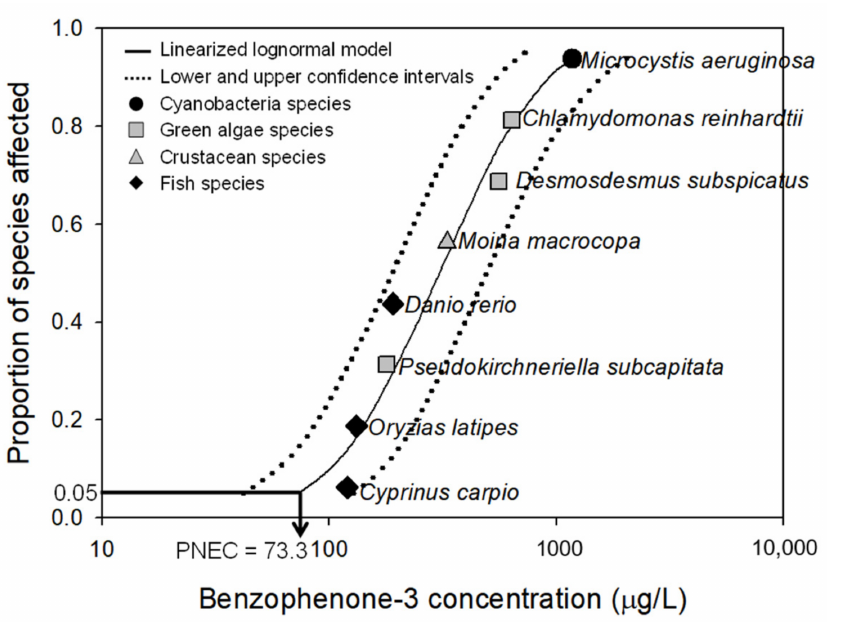
Figure 3. Species sensitivity distribution (SSD) for the chronic toxicity of benzophenone-3. Predicted no-effect concentration (PNEC) was set at the 5% hazardous concentration (HC5).